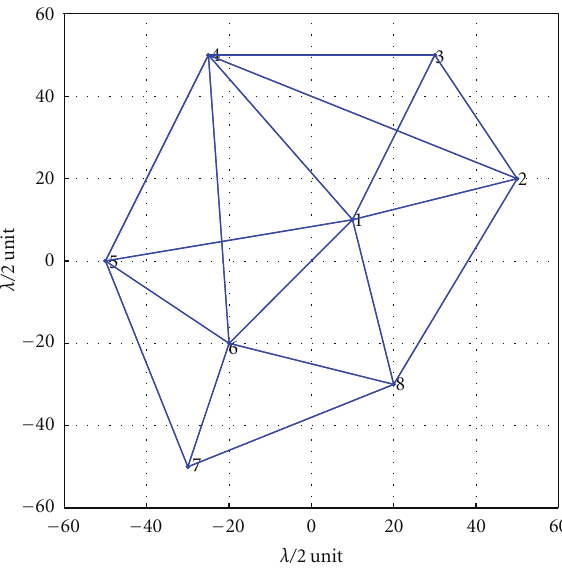
Figure 1: Network topology used for block di ff usion